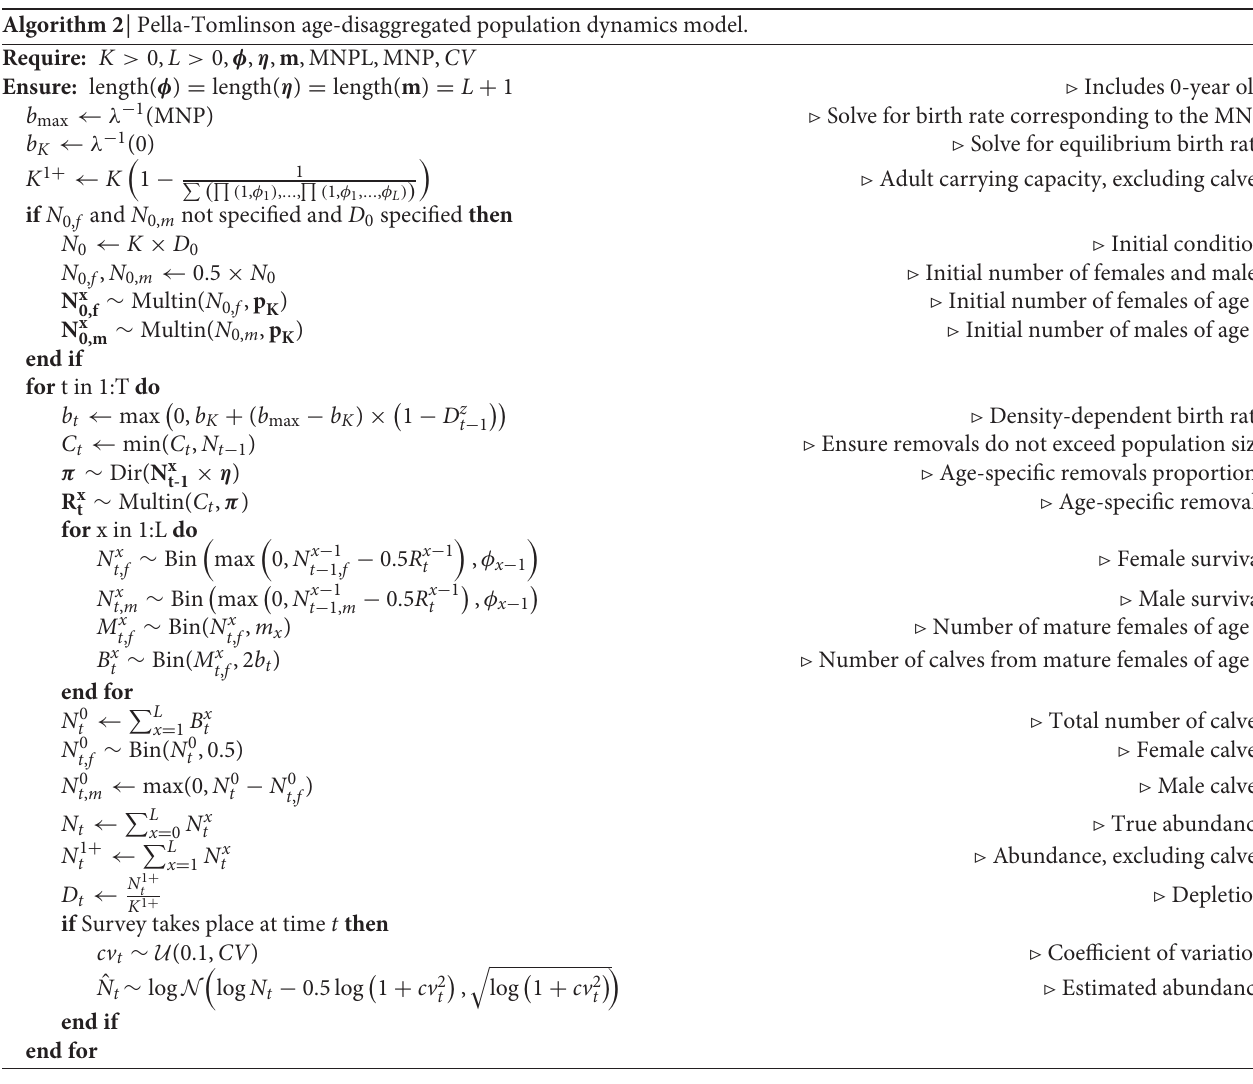
Algorithm 2 | Pella-Tomlinson age-disaggregated population dynamics